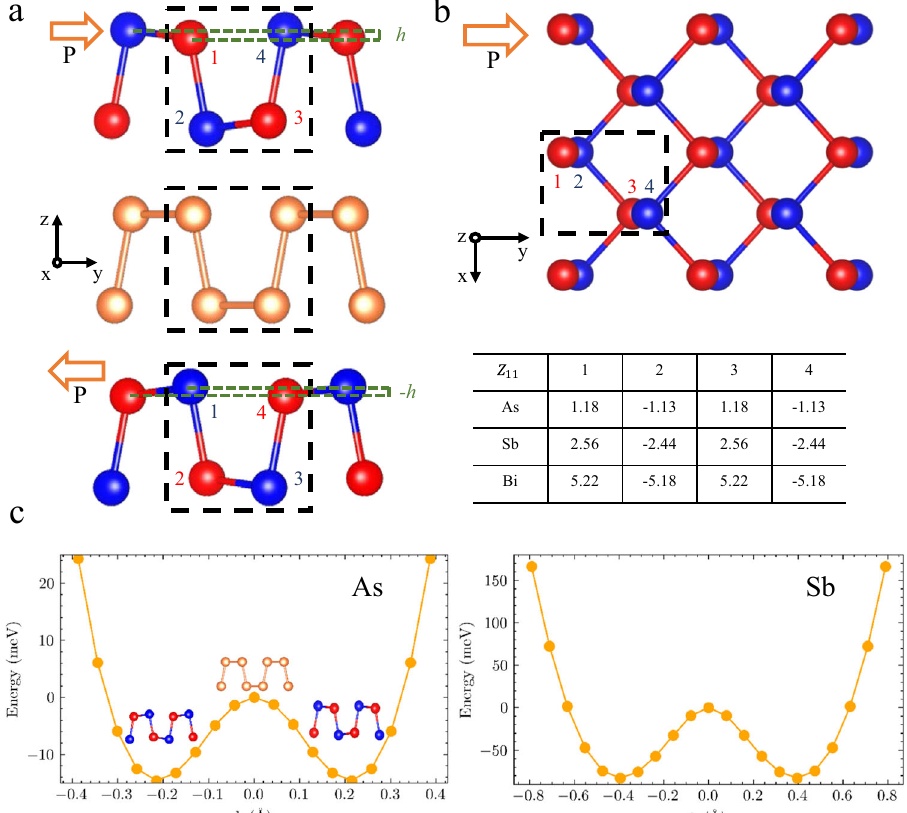
Fig. 1 Ferroelectric single-element group-V monolayers. Schematics of a side view and b top view of crystal structures of single-element group- V monolayer with in-plane polarization along the y axis. The inversion symmetry breaking results from the spontaneous atomic layer buckling denoted as h . The atoms are colored based on the sign of the Born effective charge ( Z 11 ) reported in the table (blue for negative and red for positive). c Energy evolution as a function of buckling height h in monolayer As monolayer (left) and monolayer Sb (right), revealing a double well